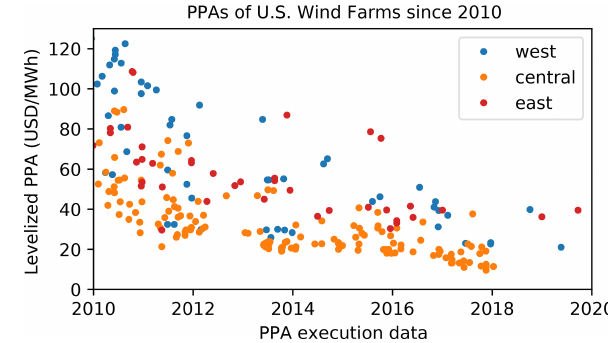
Figure 16. The PPAs for wind power plants built in the United States since 2010. Different colors represent wind plants in different regions of the United States.